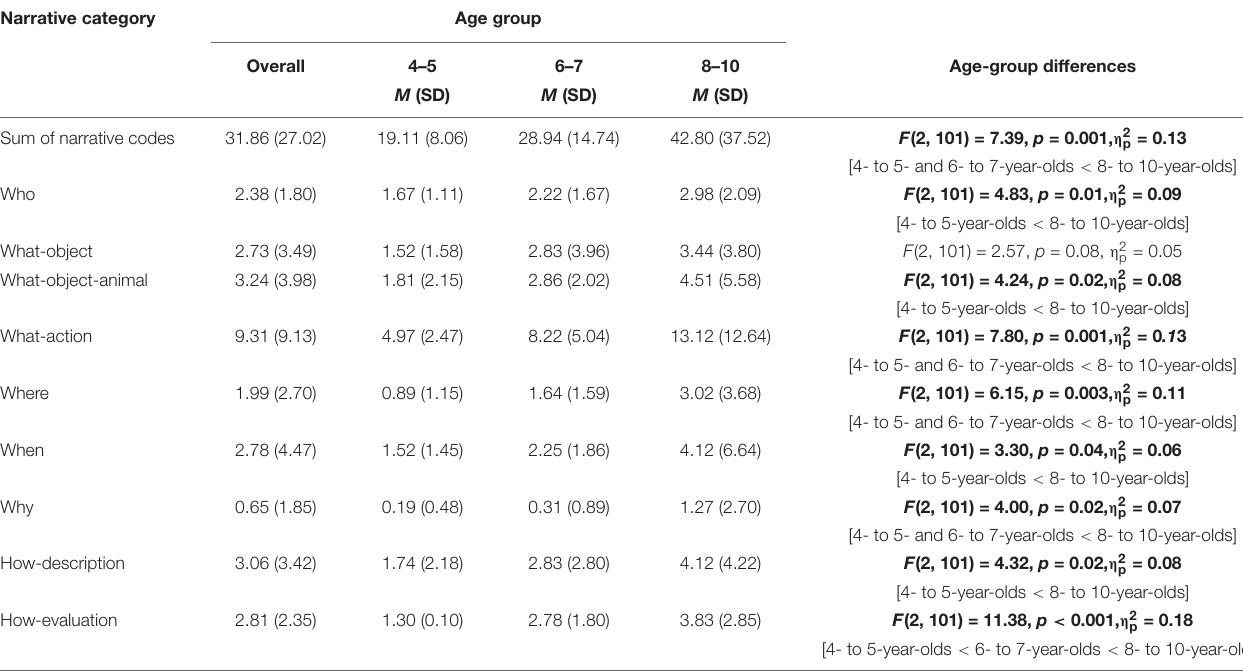
TABLE 6 | Descriptive statistics for each AM code for the experimenter-selected